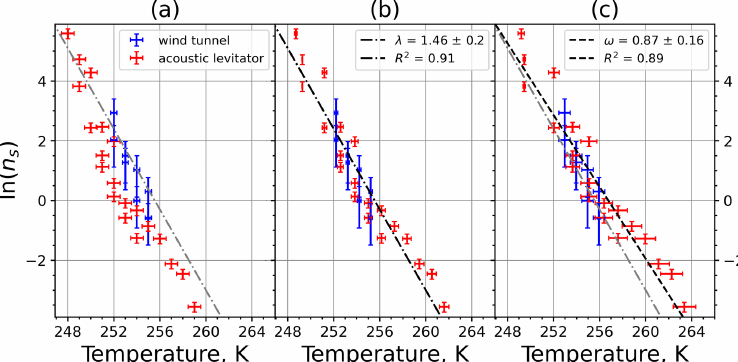
Figure A8. (a) Composite INAS density spectrum of illite NX from the uncorrected M-WT (blue) and M-AL (red) measurements. Panels (b) and (c) show the temperature-corrected data points from the M-WT and M-AL experiments based on λ and ω , respectively. The dash-dotted line in (c) is the regression line on corrected data points obtained by employing the optimal λ value as in (b)